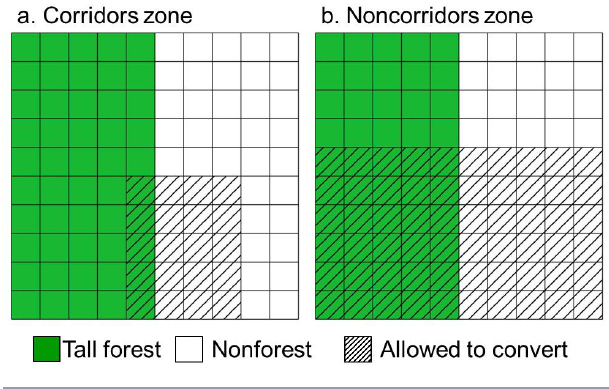
Fig. 2. Hypothetical example of two cadaster plots in Formosa, (a) inside and (b) outside the “Corridor zone”. Each cell represents 1 ha. In the Corridor zone, land conversions cannot exceed 20% of the total cadaster plot area. Likewise, not more than 10% of the area covered by tall forest can be deforested and not more than 60% of the low forests in each cadaster plot can be deforested. Plot (a) with a total of 100 ha contains 50 ha of tall forest and 50 ha of nonforest natural cover (e.g., wetlands or grassland). A landowner can then convert a maximum of 20 ha, of which only 5 ha (i.e., 10% of 50 ha) can be tall forest. In the “Noncorridor zone”, total conversion cannot exceed 60% of the plot area, with maximum total deforestation of 60% for both forest types. Thus, in plot (b) up to 60 ha could be converted to agriculture, but only 30 ha of tall forest can be